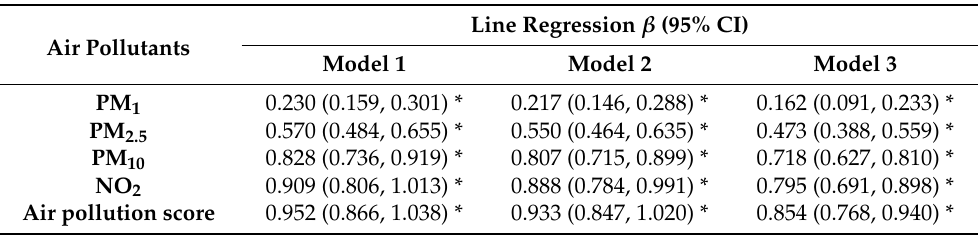
Table 2. Estimated independent and air pollution scores of ambient air pollutants (per IQR increment) on cardiometabolic